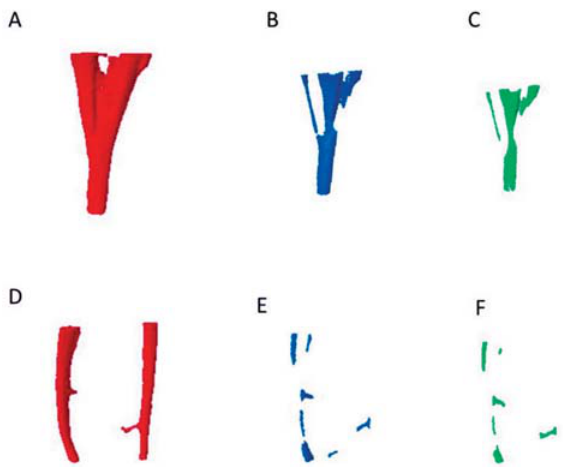
Figure 2- Images A, B and C represent the mesial root of a mandibular molar with the presence of an isthmus, and